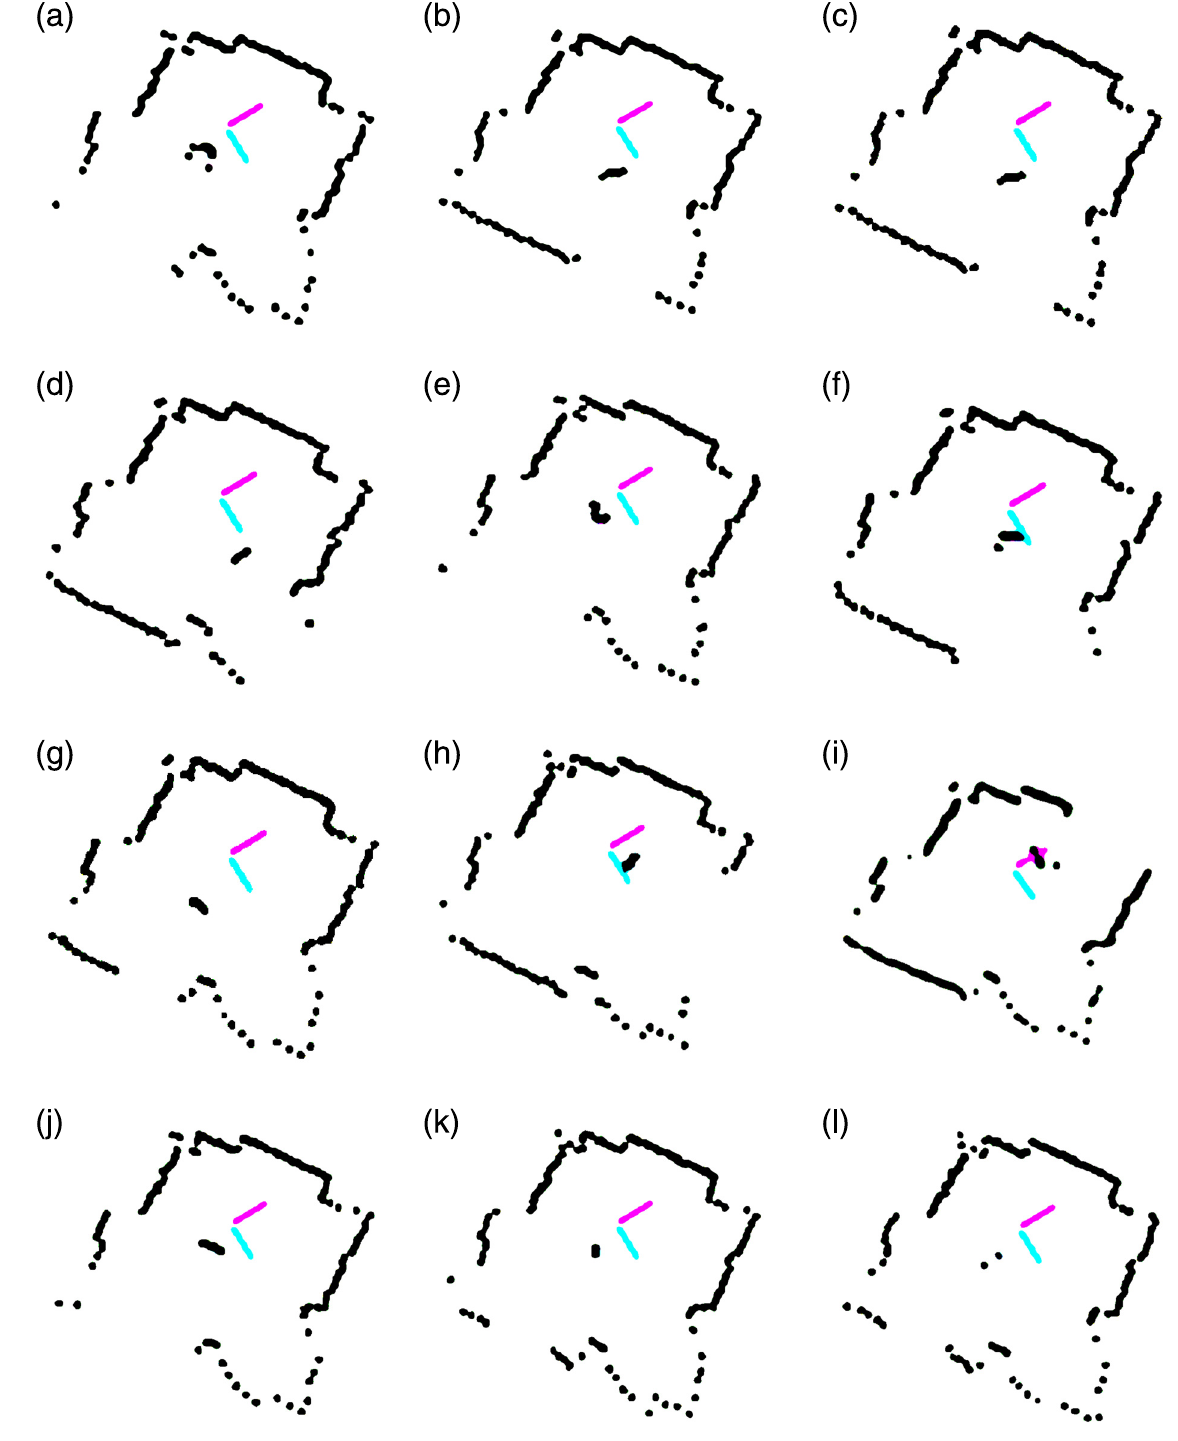
Fig 7. Human moving in a room (a to l).